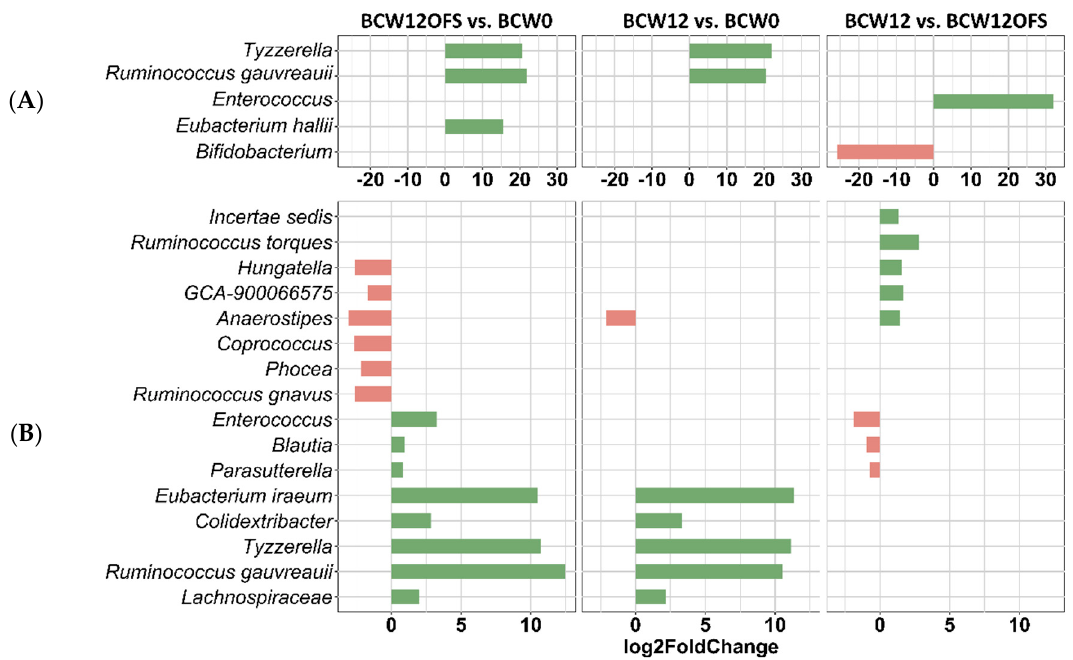
Figure 10. Mouse gut microbiota differential abundance analyses. Taxa found to be differentially abundant between groups are represented by log2FoldChange from DESeq2 analysis. The group serving as the base for comparison comes after “vs.” (i.e., BCW12OFS vs. BCW0 is showing values for the bacteria in BCW12OFS compared to BCW0). Positive log2FoldChange indicates greater relative abundance, while a negative value indicates lesser relative abundance. Significantly differential abundance for each comparison at day 13 are presented ( A ). Significantly differential abundance for each comparison at day 22 are also presented ( B ). Only differences with p < 0.001 from DESeq2 analysis are represented. BCW0 ( n = 10), BCW12 ( n = 12), BCW12OFS ( n = 12). Serum cytokines were far more refractory to change compared to tumor